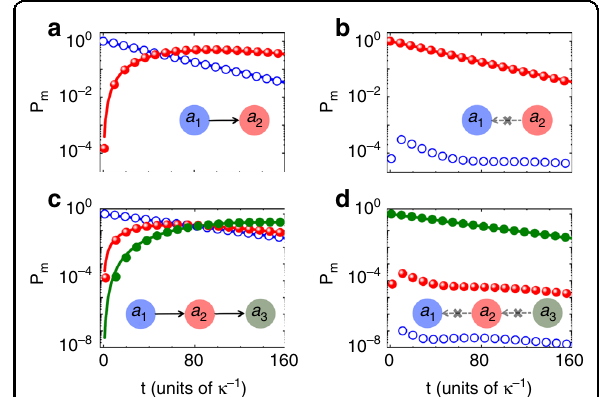
Fig. 5 Unidirectional energy transmission. a , b Time evolution of the energy in the fi rst main mode a 1 (blue) and the second main mode a 2 (red) for energy initially stored in the leftmost mode ( a ) and the rightmost mode ( b ). c , d Time evolution of the energy in a 1 (blue), a 2 (red), and a 3 (black) for energy initially stored in the leftmost mode ( c ) and the rightmost mode ( d ). The curves are calculated from the effective Hamiltonian (2) and the dots are obtained from the original Hamiltonian (1). The insets illustrate the energy fl ow direction. The parameters are the same as in Fig. 4, with Δ ϕ ¼ (cid:2) π =